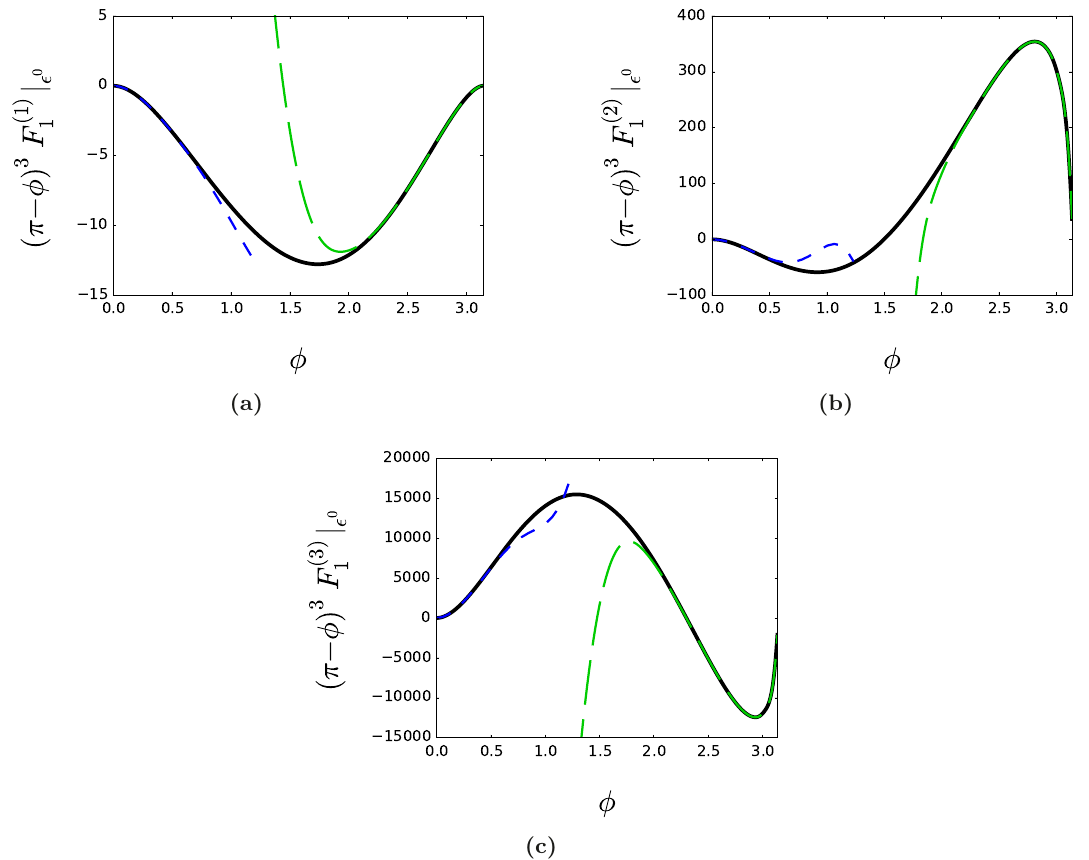
Figure 7. Panels (a), (b) and (c) show the real part of the ǫ 0 term of ( π − φ ) 3 F 1 ( q 2 ) at one-, two- and three-loop order, respectively. The solid (black) lines correspond to the exact result and the dashed lines to